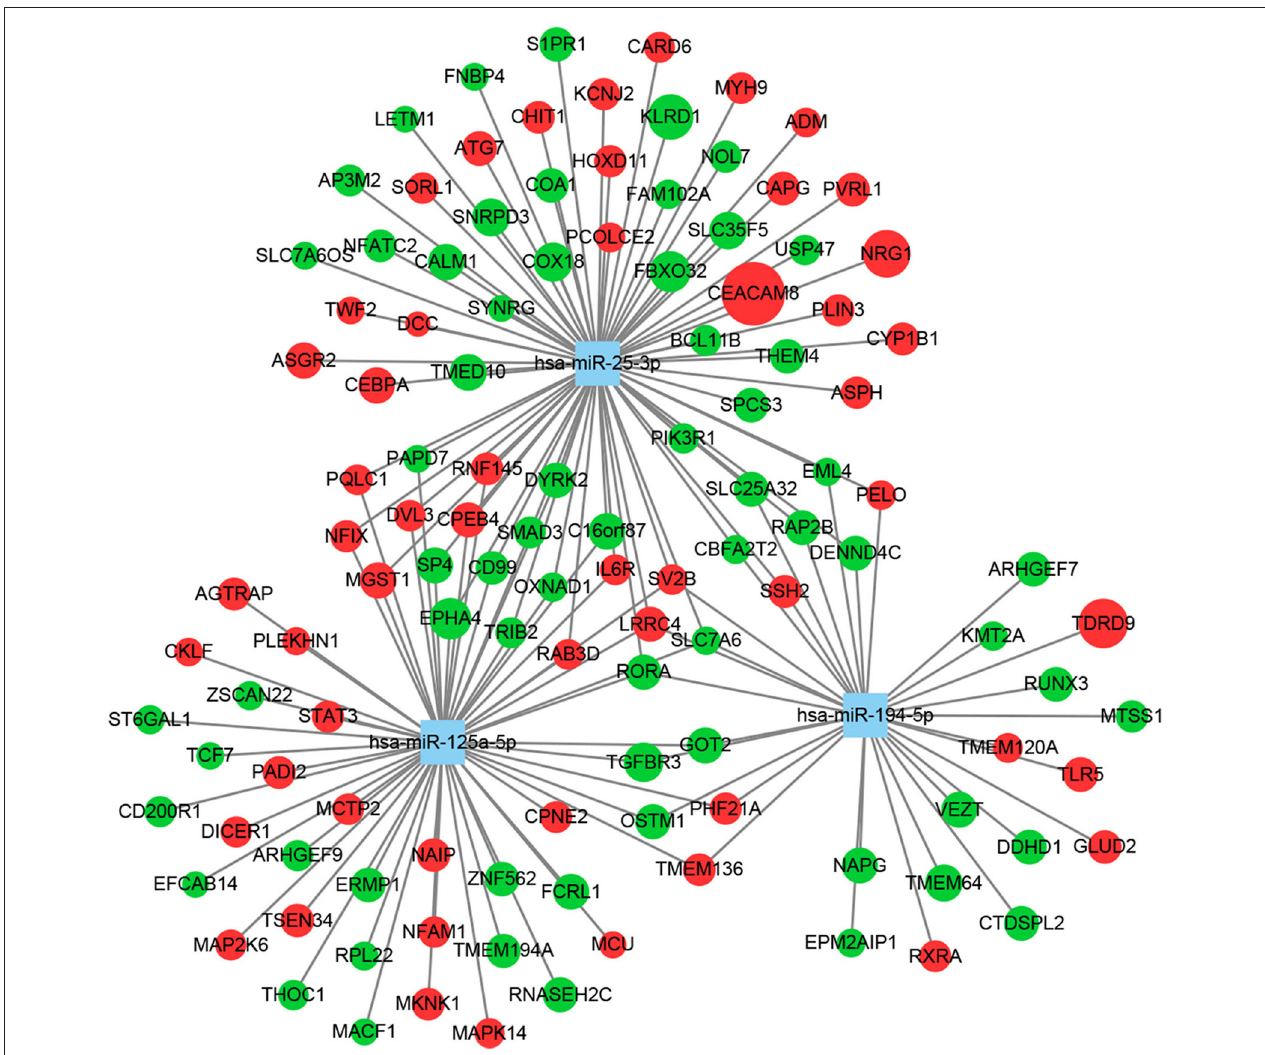
FIGURE 2 | Construction of a miRNA–mRNA regulatory network using Cytoscape. Squares represent miRNAs, circles represent mRNAs, green indicates downregulation, red indicates upregulation, and circle size reflects the degree of change.